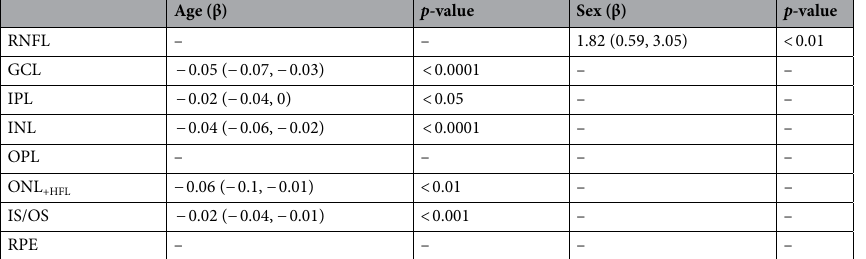
Table 2. Multi-variable regression characteristics of participant demographics versus average retinal thicknesses. The coefficients (95% CI) below represent final significant values included in each multi-variable model for each layer, based on backward step-wise elimination of